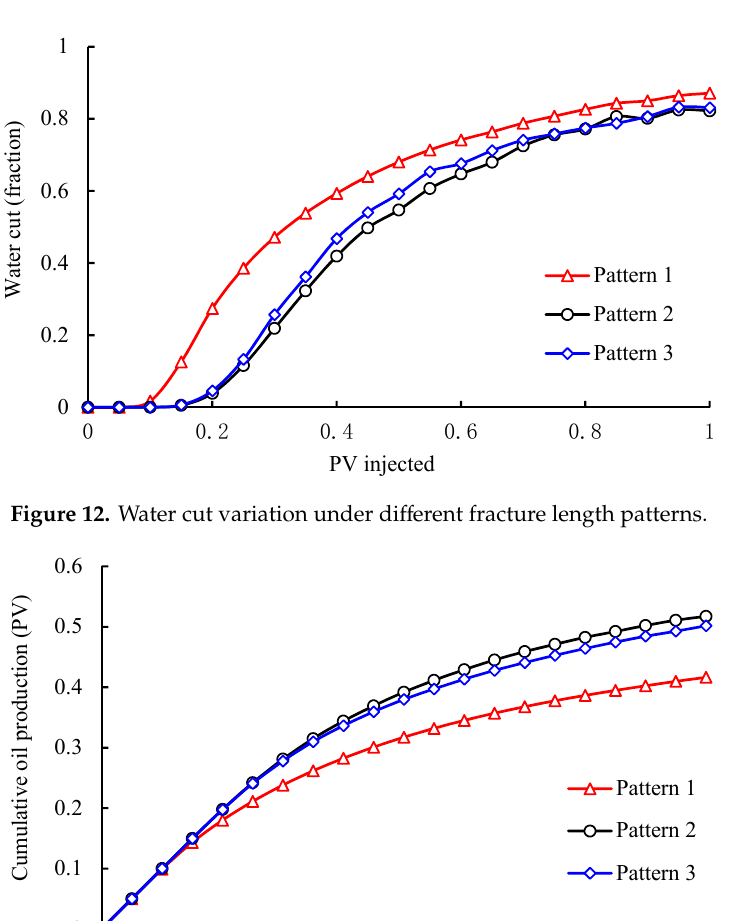
Figure 13. Cumulative oil production variation under different fracture lengths.